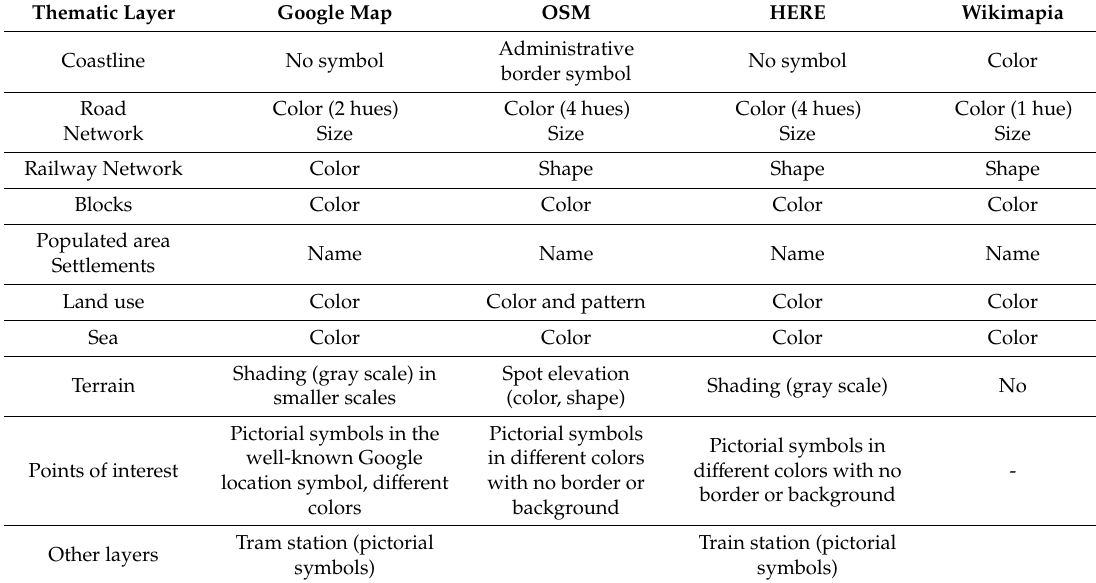
Table 5. Visual variables applied in map symbols for each thematic